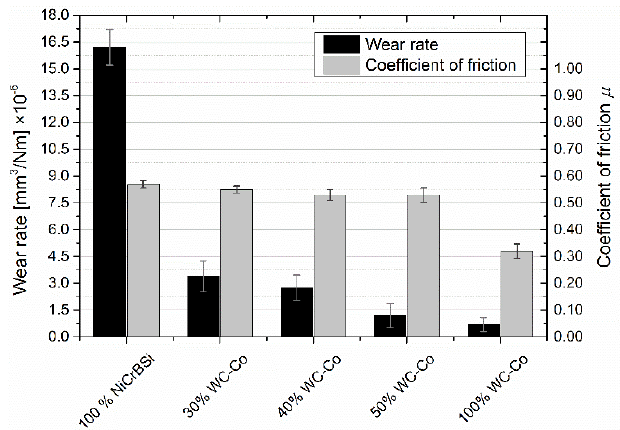
Figure 12. Histogram of the wear rate and